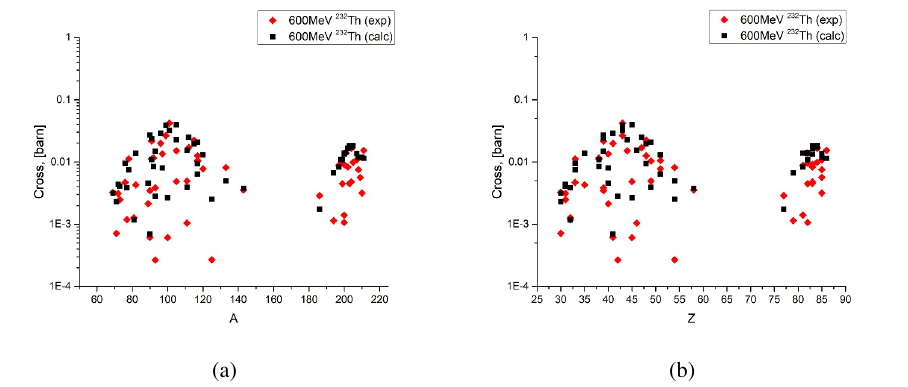
Figure 4: Graph of the cross sections for thorium irradiated by 600 MeV protons